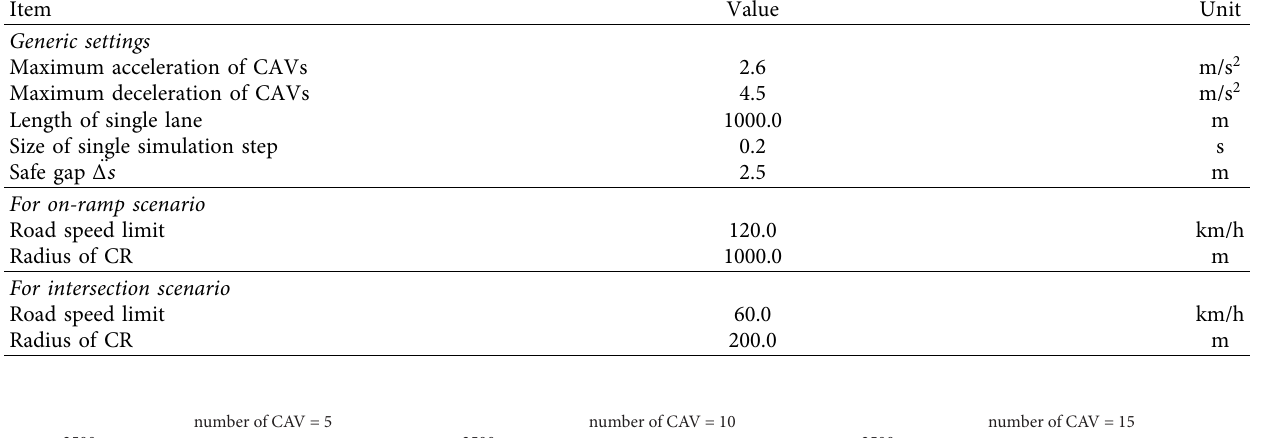
Table 1: Parameter configuration in